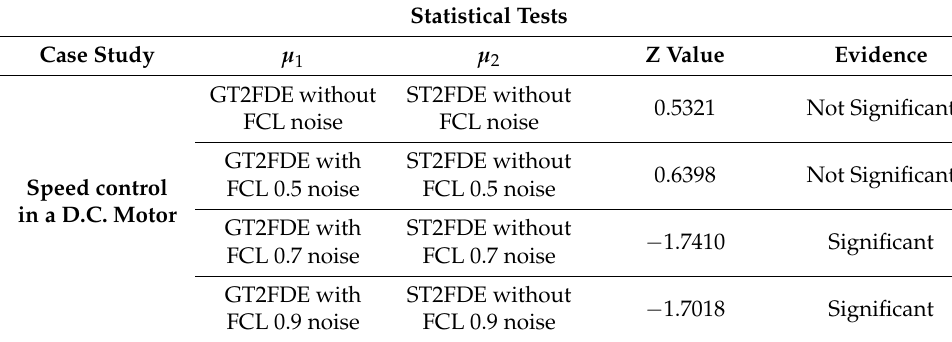
Table 8. Summary of results of the statistical